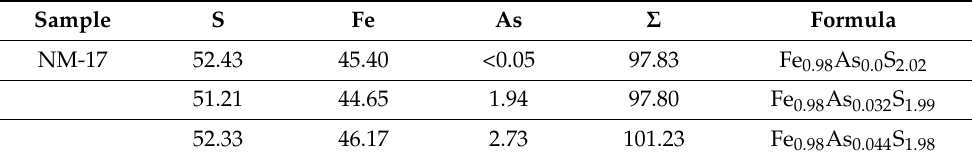
Table 1. Chemical composition of pyrite, wt%.